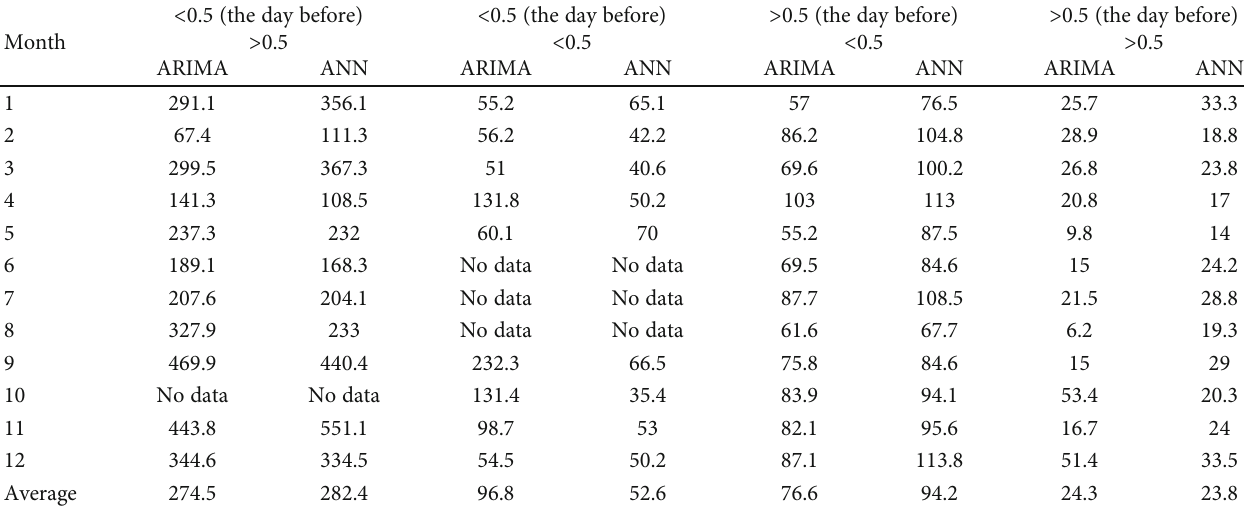
index . Processed data from the 2009 year for a forecasting period of DR